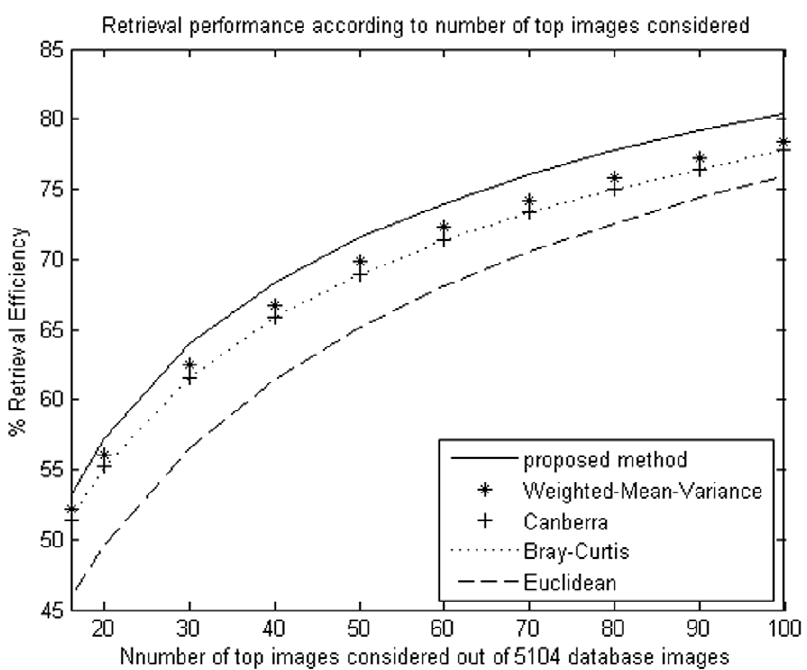
Figure 10. Average retrieval rate of database according to the number of top retrieved images using DT-CWT. The Outex image database (5104 images) were used.